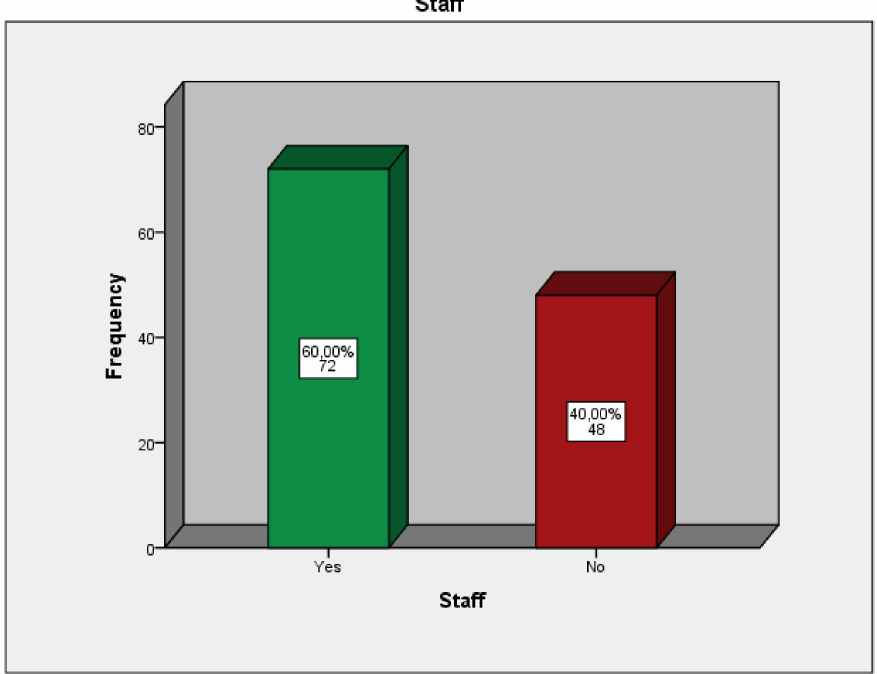
Figure 2. Presence or absence of dental assistant(s)-staff in the orthodontic